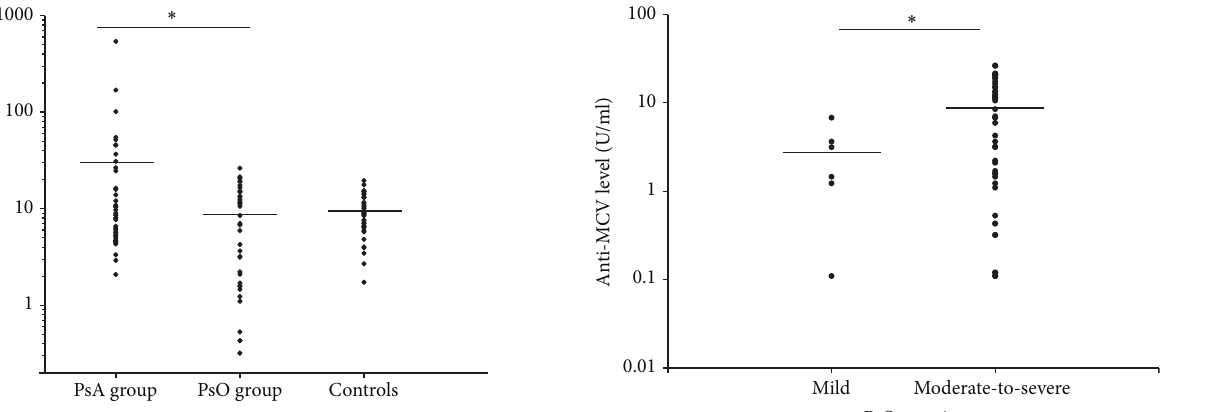
Figure 1: Anti-MCV titers are higher in PsA patients than in patients with psoriasis without arthritis and in healthy volunteers. The plots show the antibody levels of the investigated patients. The horizontal lines indicate the mean levels of anti-MCVs. The mean autoantibody level in the PsA group was 30.32 ± 82.14 U/mL as compared with 8.71 ± 7.41 U/mL in the PsO group and 9.50 ± 4.23 U/mL in the healthy control group. ∗ The difference between the data on the PsA and PsO groups was statistically significant ( 𝑃 < 0.05 ).